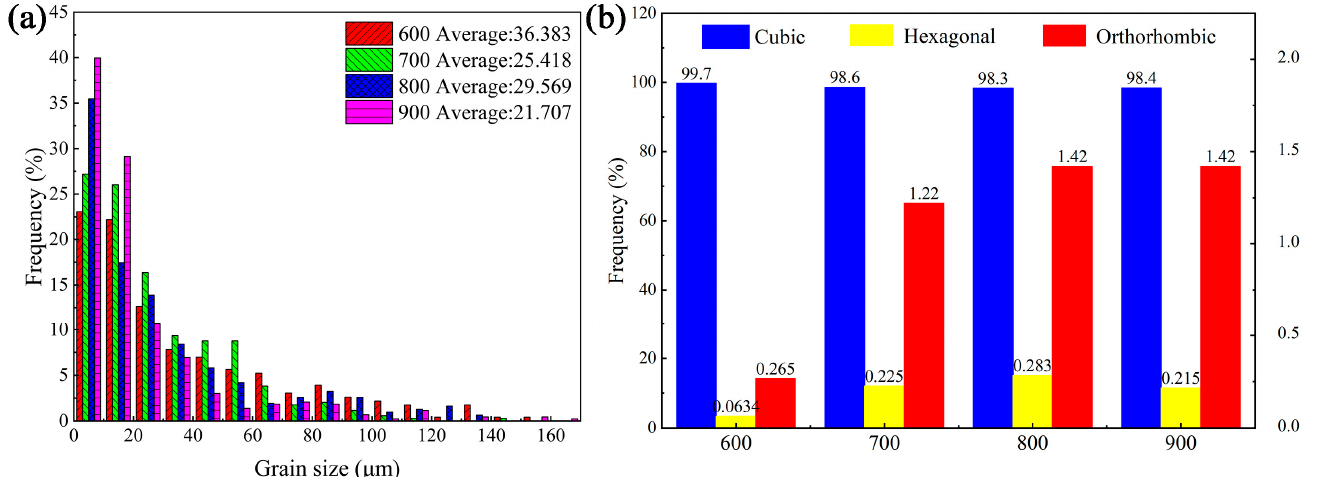
Figure 12. ( a ) Distribution of grain size and ( b ) volume fraction of the phases in the Ti-22Al-25Nb alloy formed via SLM at four scanning speeds.